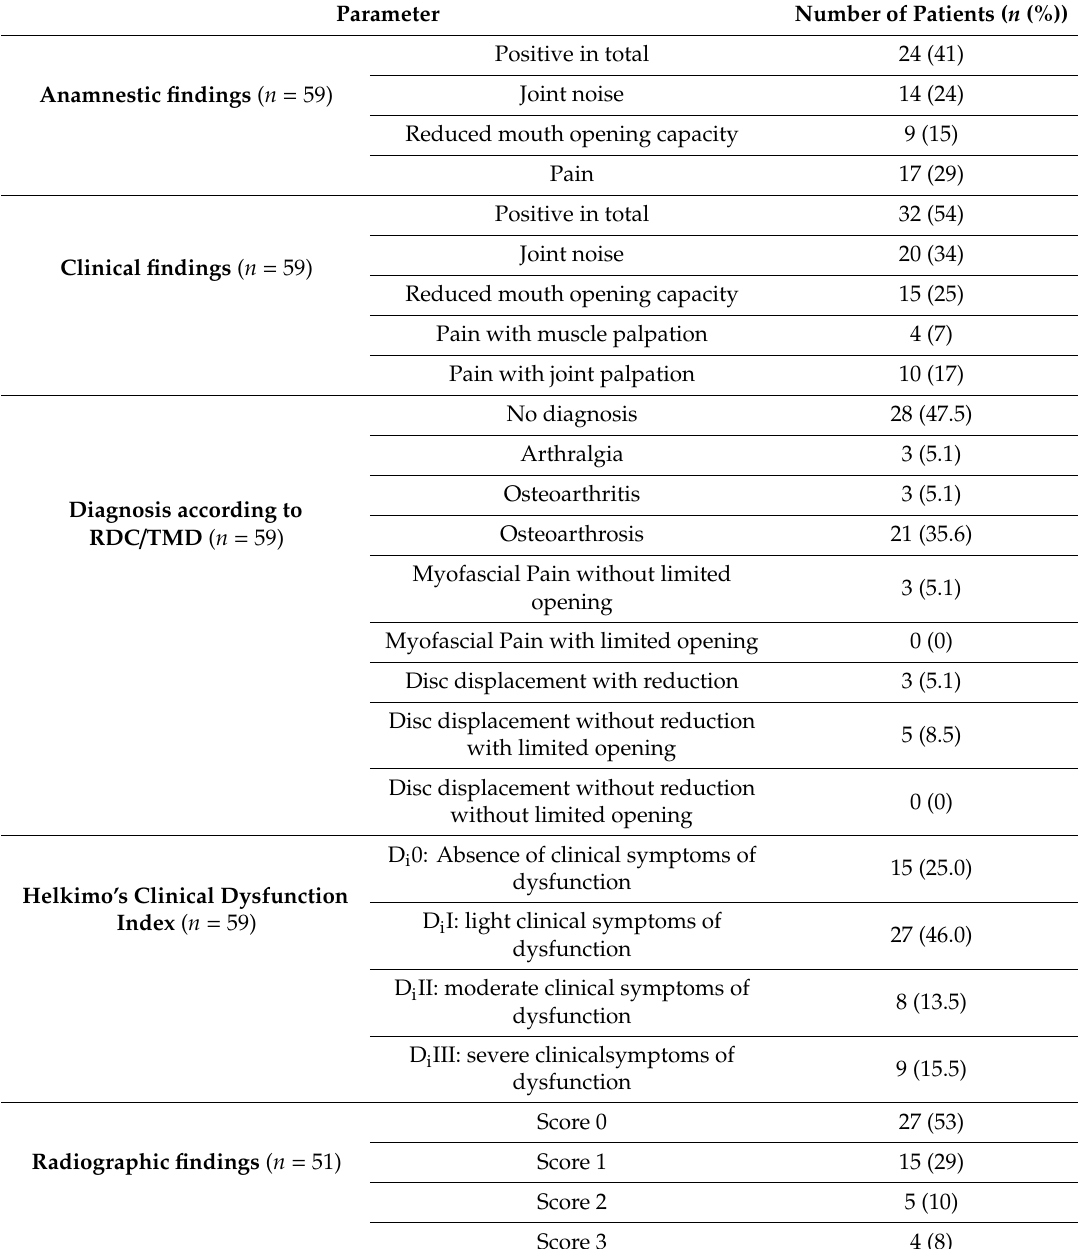
Table 2. Anamnestic, clinical and radiographic